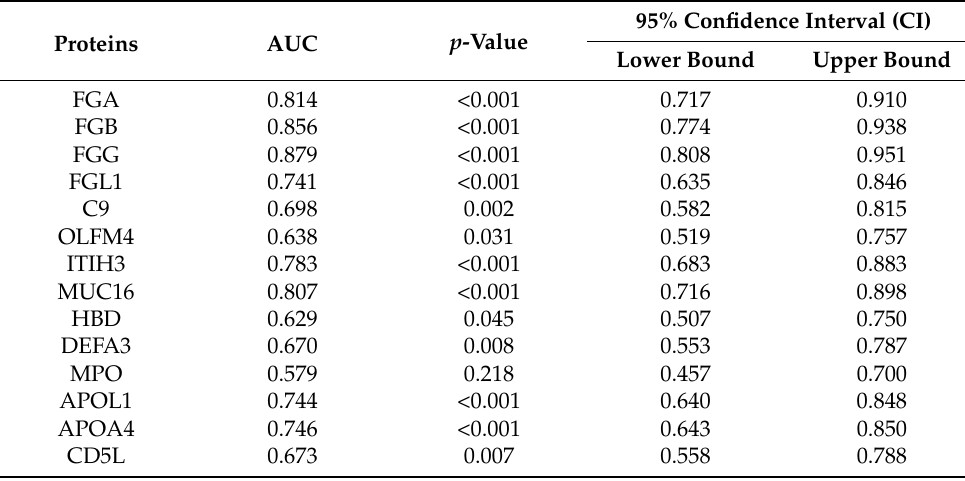
Table 3. Area under the ROC curve of proteins for diagnosis of ovarian